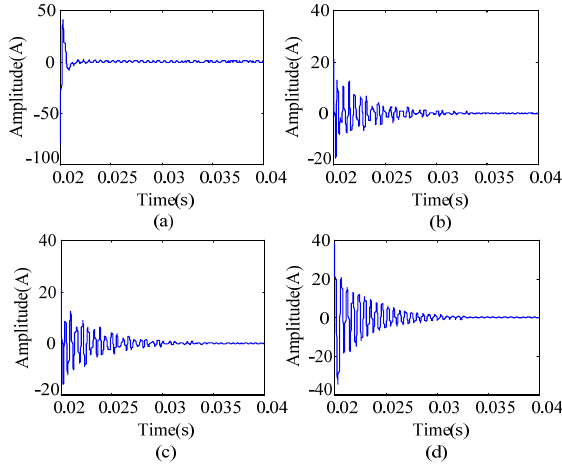
Figure 9. IMF2 components of each outgoing line. ( a ) Lian L 1 ; ( b ) Lian L 2 ; ( c ) Lian L 3 ; ( d ) Lian L 4 .